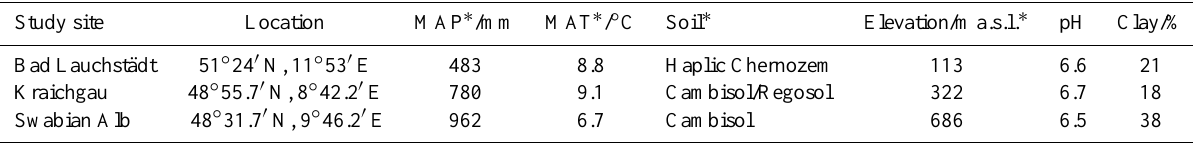
Table 1. Study site